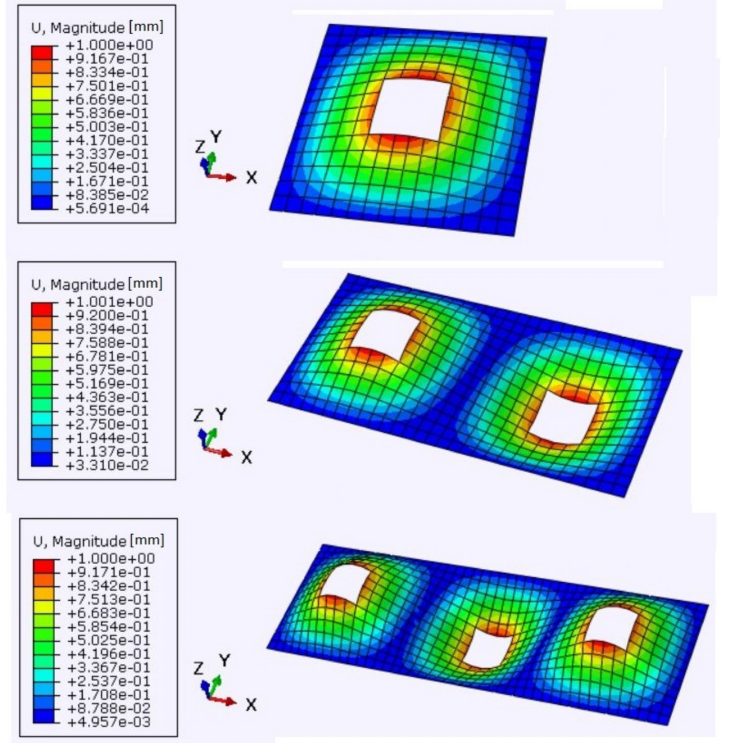
Figure 7. First buckling modes of plates with square cut-outs and their normalized displacement